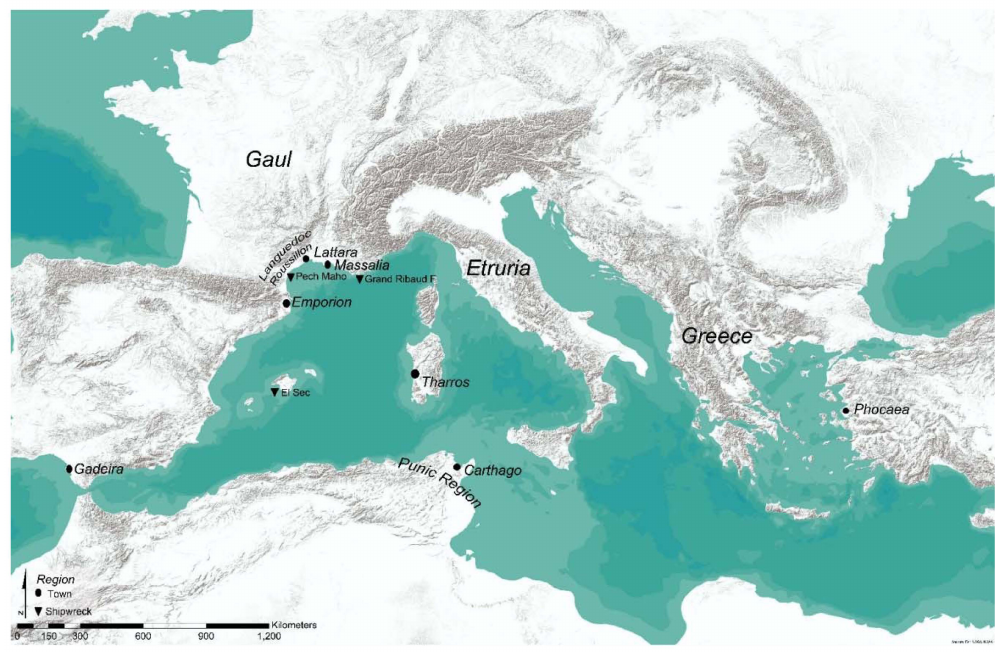
Figure 2. Area of interest for this study. This study specifically examines the development of viticulture and trade in the Languedoc Roussillon region, but map includes surrounding areas of interest to this study. Here I show those cities that are specifically mentioned in this manuscript, as well as the three shipwrecks mentioned that show integration of ethnic